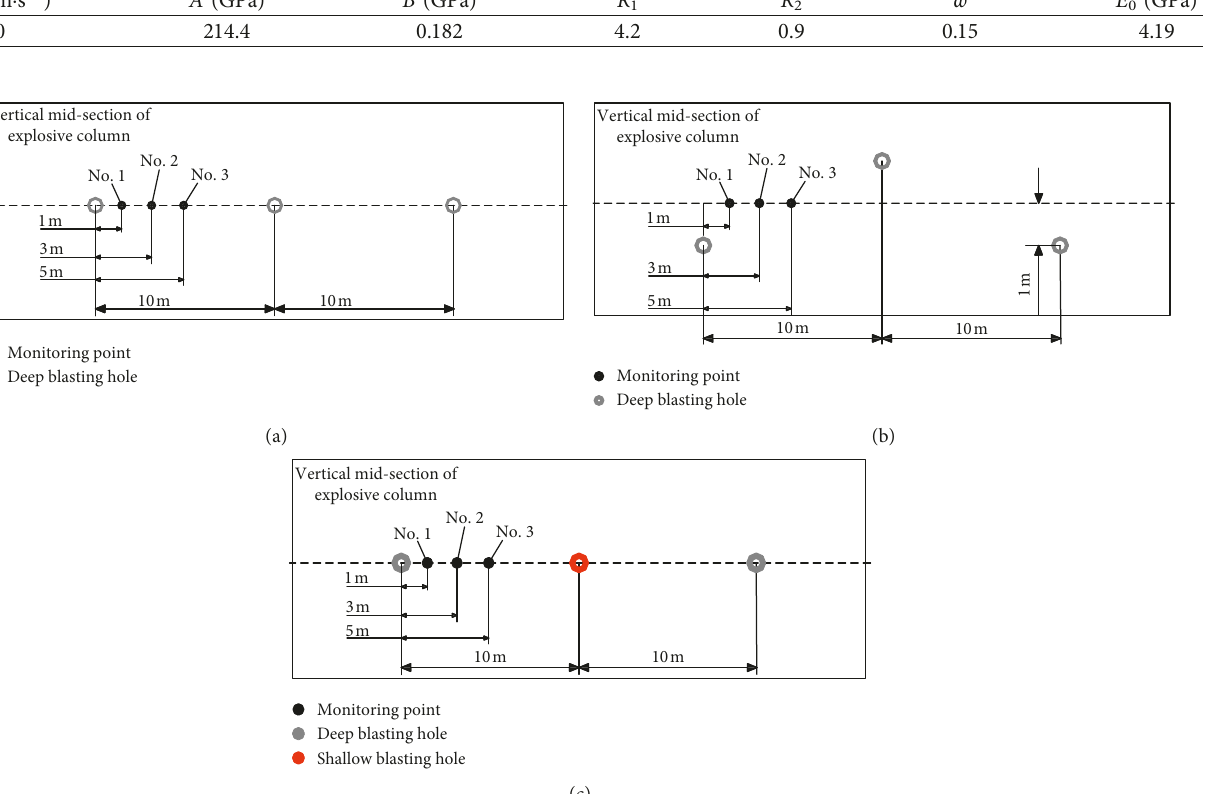
Figure 12: Location of monitoring points. (a) “Straight-line” blasting layout monitoring point location. (b) “Triangle-fractal” blasting layout monitoring point location. (c) “Deep-shallow-fractal” blasting layout monitoring point location.